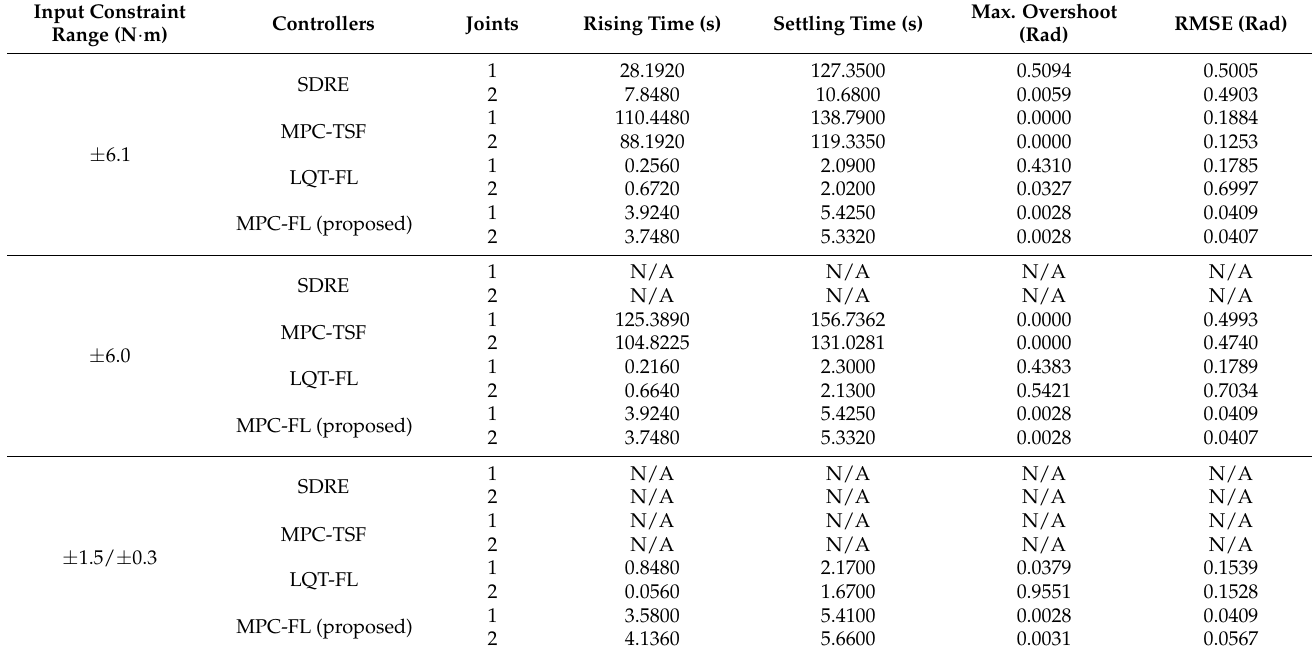
Figure 13. Two-link robot arm by applying the four control schemes with input constraints ± 1.5 and ± 0.3 N · m respectively for joints 1 and 2: ( a ) output responses of joint 1; ( b ) output responses of joint 2; ( c ) input signals of joint 1; ( d ) input signals of joint 2. Table 7. Comparisons of control performances by applying the four control schemes with input constraints to the two-link robot